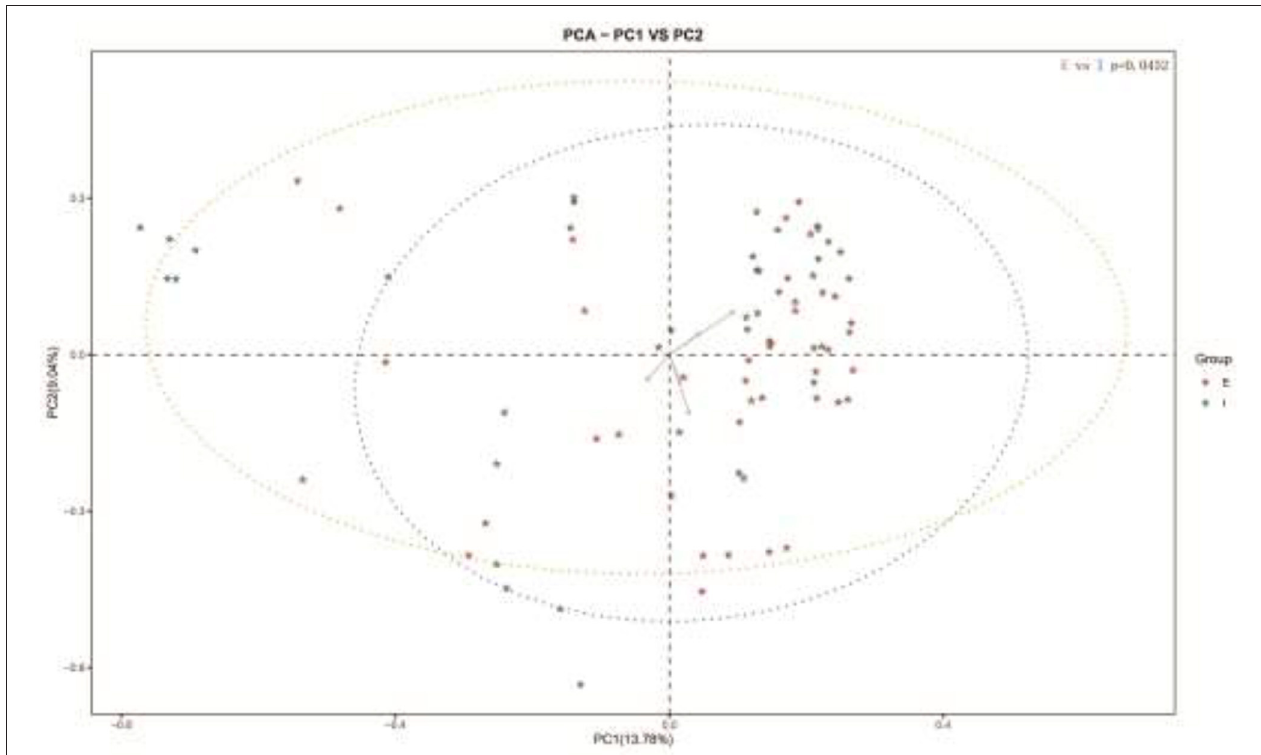
FIGURE 2 | Beta analysis of microbial diversity in sputum samples of COPD frequent exacerbators and COPD infrequent exacerbators. E represented COPD frequent exacerbators; I represented COPD infrequent exacerbators. COPD, chronic obstructive pulmonary